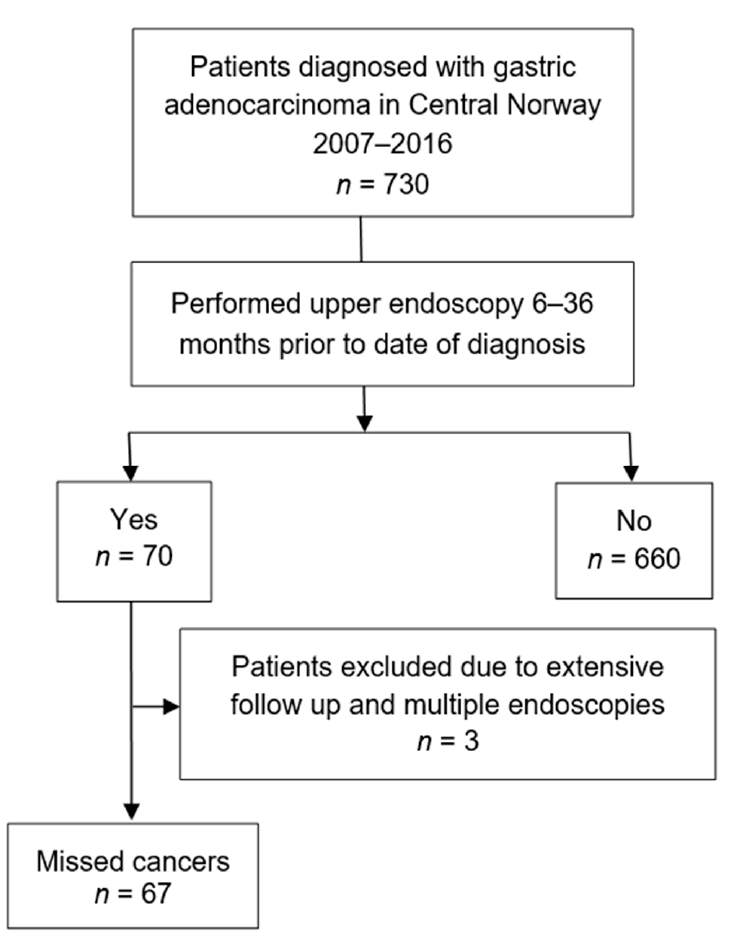
Figure 1. Flow diagram of study population.